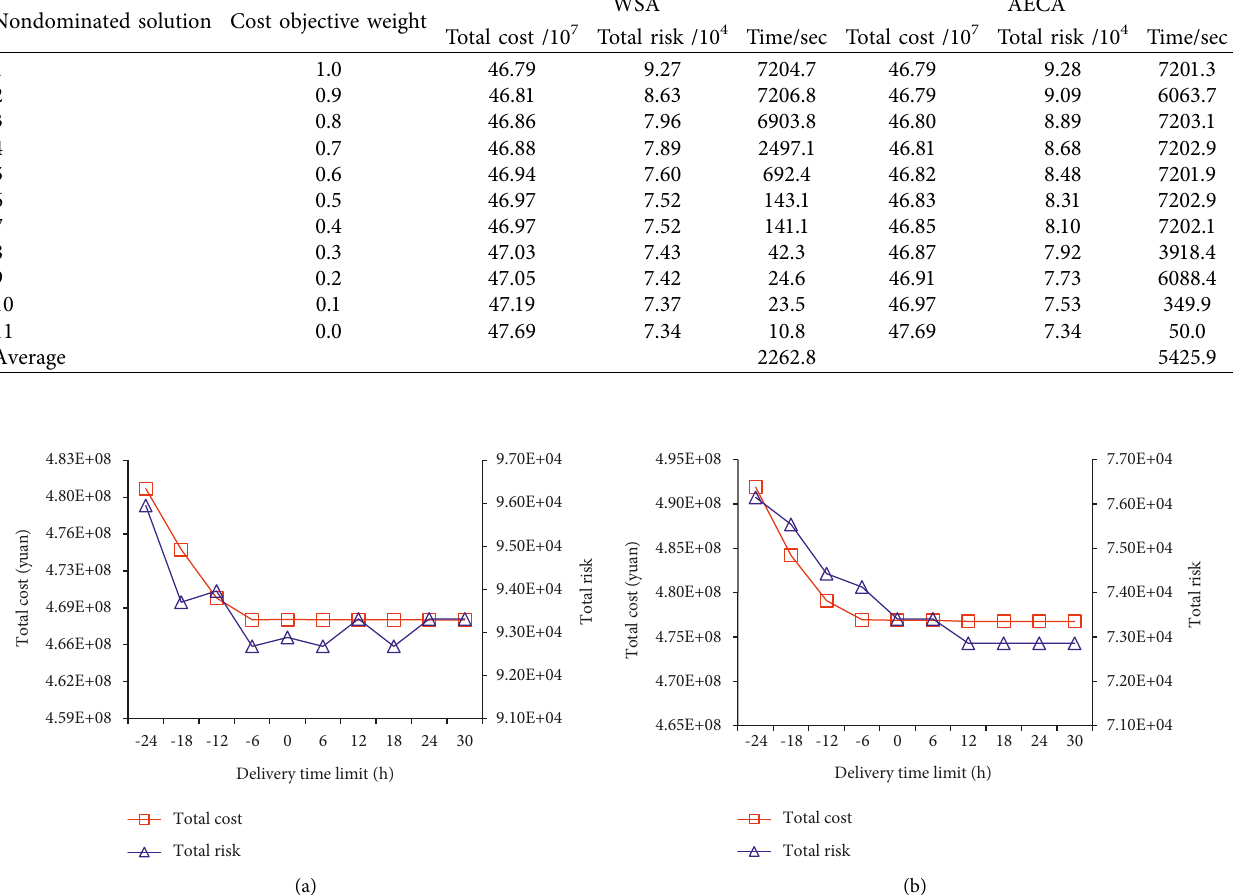
Table 6: Comparison of